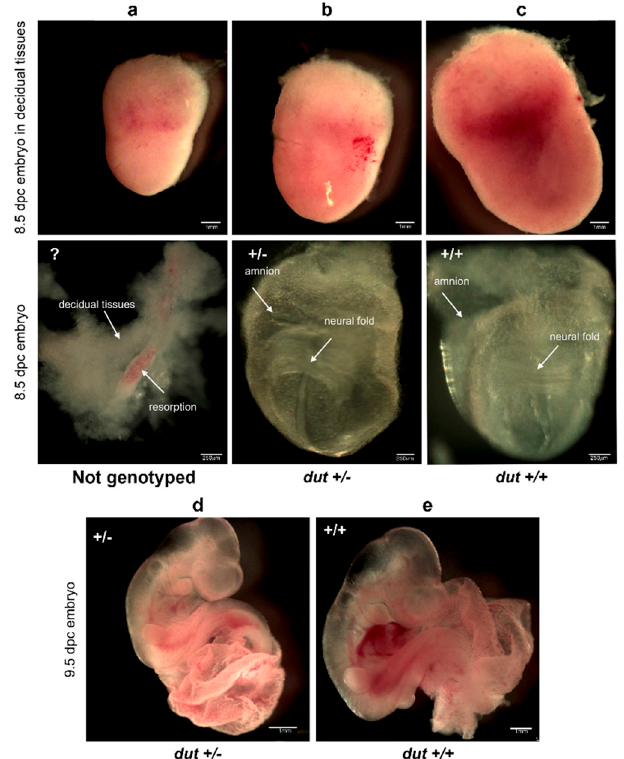
Figure 4. Images of embryos at 8.5 and 9.5 dpc obtained by crossing D47 heterozygous mice. ( a ) Representative image of a resorbed embryo at 8.5 dpc covered by decidual tissues. The resorbed embryo could not be genotyped as indicated with “?”. Heterozygous (+/ − ) ( b ) and wild-type (+/+) ( c ) embryos at 8.5 dpc are shown. Upper panels show embryos in intact decidual tissues. Scale bar represents 1 mm. Lower panels show the embryos dissected from decidual tissues. Arrows indicate the embryonic neural fold and the extra-embryonic amnion. Scale bar represents 250 µ m. Heterozygous (+/ − ) ( d ) and wild-type (+/+) ( e ) embryos at 9.5 dpc are also shown. Scale bar represents 1 mm.